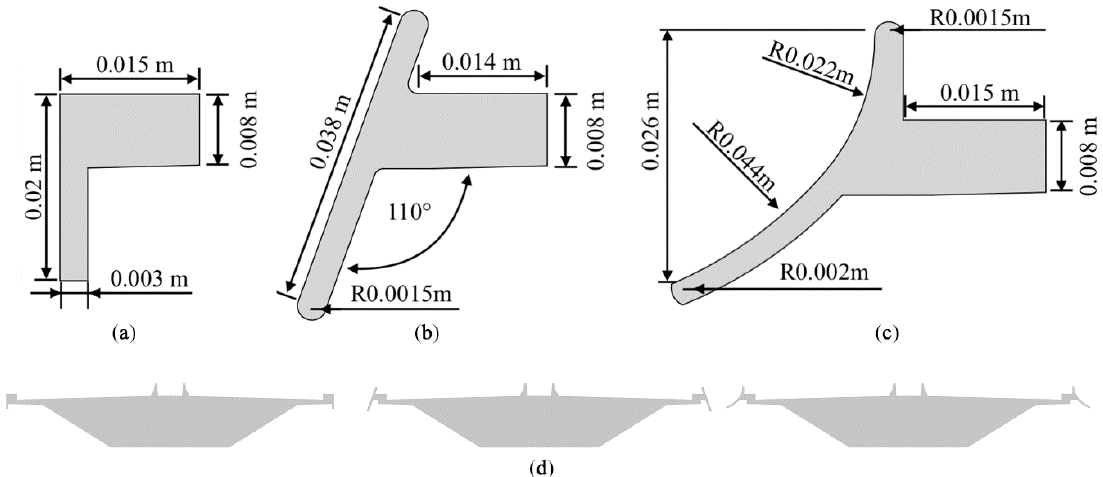
Figure 23. Fascia beams considered in the design: ( a ) Vertical fascia beam; ( b ) Inclined fascia beam; ( c ) Curved fascia beam; ( d ) Locations of fascia beams on the